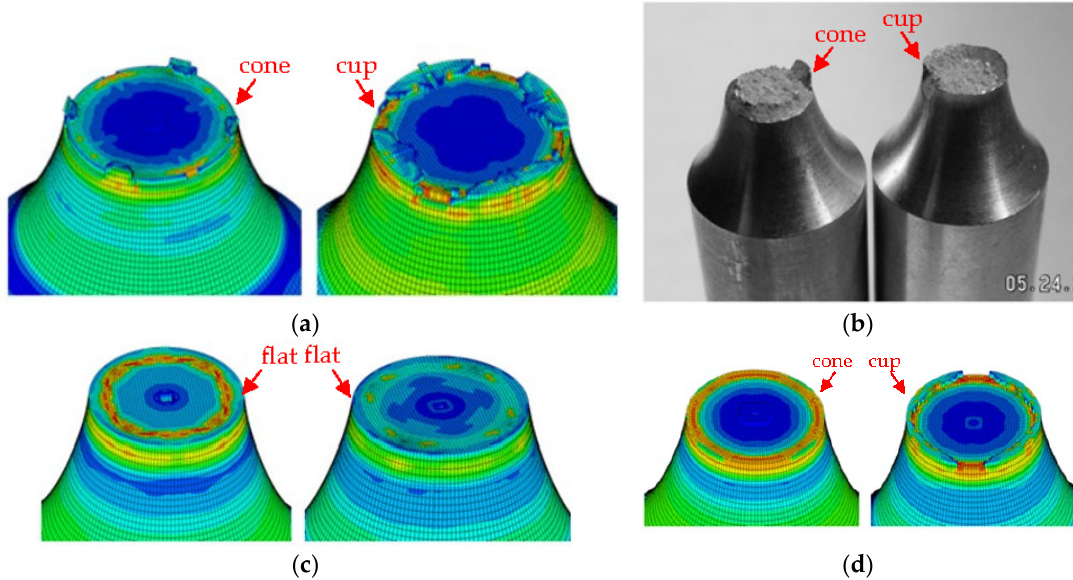
Figure 18. Comparisons of the model predictions with the experimentally observed failure pattern (cup and cone) of the 2024-T351 aluminum alloy smooth round bar specimen in tension at room temperature. (a) The present model, (b) the experimental observation [52], (c) the JC constitutive model with the JC failure criterion and (d) the JC constitutive model with the BW fracture criterion.